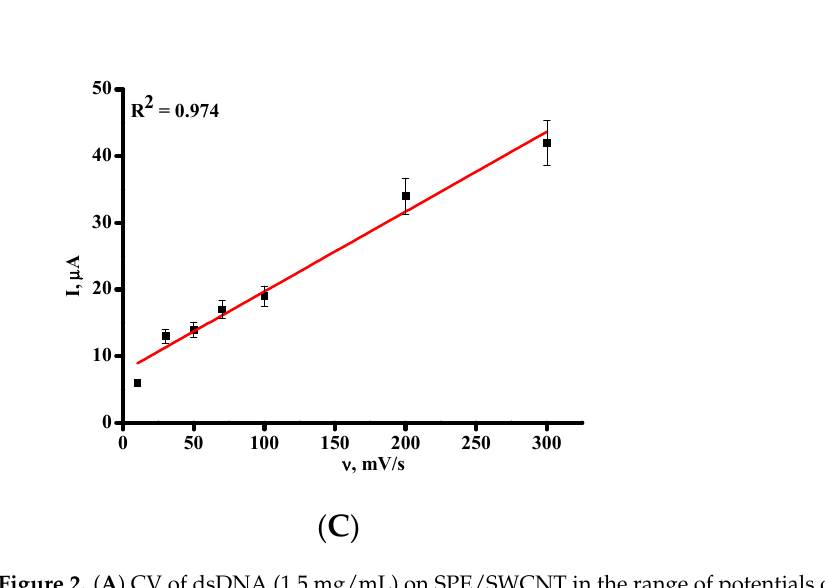
Figure 2. ( A ) CV of dsDNA (1.5 mg/mL) on SPE/SWCNT in the range of potentials of 0 V to 1.2 V at scan rates from 10 to 300 mV/s. Dependence between guanine ( B ) and adenine ( C ) peak currents and the scan rate.